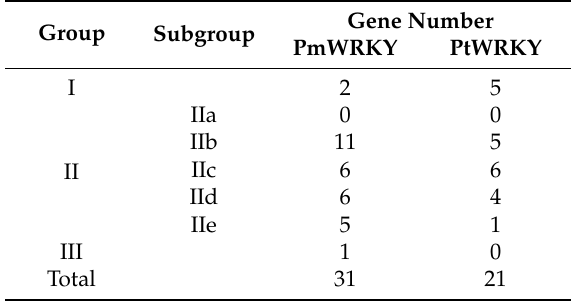
Figure 2. Multiple sequence alignment of PmWRKY domains. Table 2. Comparison of groups between P. massoniana and P.